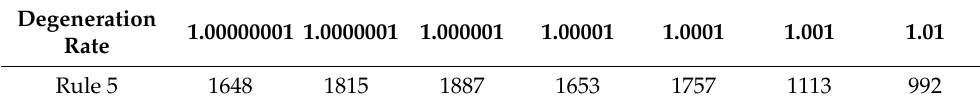
Table 4. Effect of degeneration rate on low-probability password hits (Rule